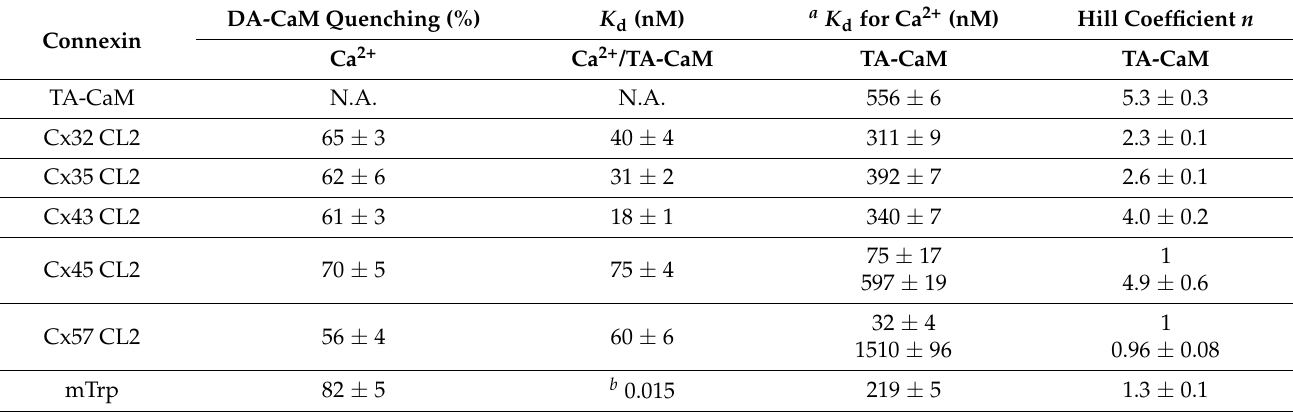
Table 2. Interaction of Cx CL2 peptides with TA-CaM and DA-CaM in the presence of Ca 2+